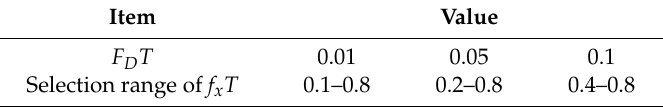
Figure 6. Correlation coefficient of interference signals between two branches when F D T < 0.1. Table 1. Selection range of artificial shift frequency.